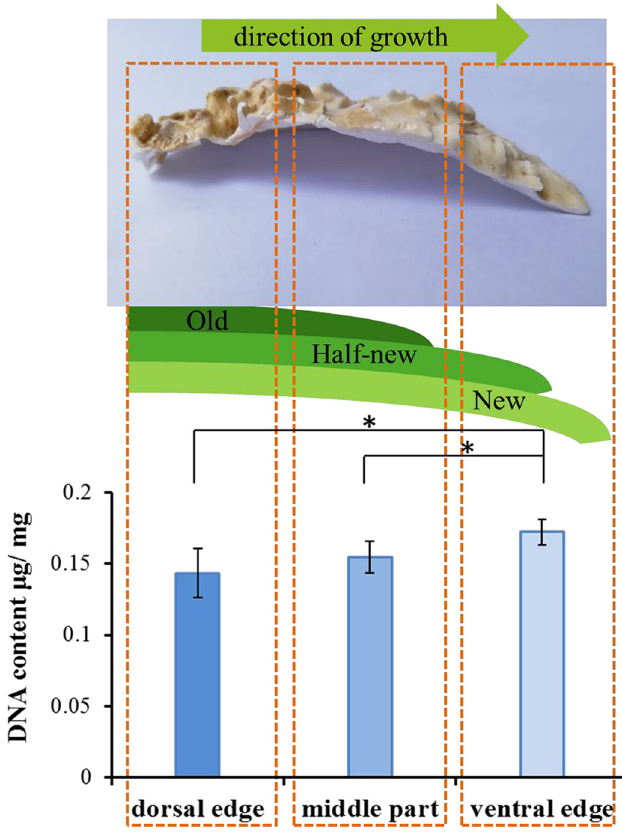
Fig. 5. Comparison of the DNA content in the ventral, middle, and dorsal edges of C. gigas shells. Each bar represented mean ±SD ( n =6). *( P < 0.05). “ Old ” represents the earliest secreted shell. “ New ” represents the shell that has been secreted most recently. “ Half-new ” represents the shell produced between the earliest and most recent shell